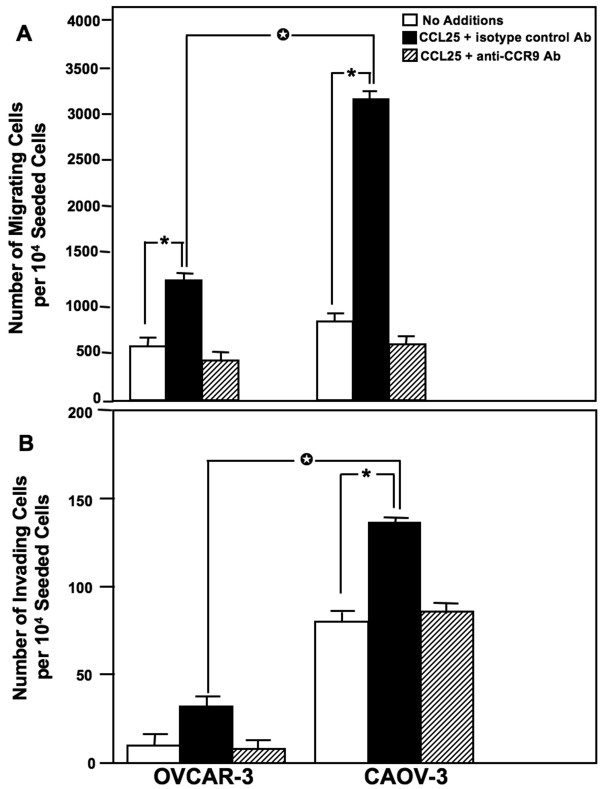
CCR9-mediated ovarian cancer cell migration and invasion. (A) OVCAR-3 and CAOV-3 cells were tested for their ability to migrate toward chemotactic gradients of CCL25. Cells were co-cultured with 1.0 μg/mL mouse anti-CCR9 antibody during migration assays using 100 ng/mL of CCL25. (B) OVCAR-3 and CAOV-3 cells were also tested for their ability to invade or translocate across Matrigel™ matrix in response to 100 ng/mL of CCL25. Cells were co-cultured with 1.0 μg/mL monoclonal antibodies against CCR9 during invasion assays using 100 ng/mL of CCL25. The number of cells ± SEM that migrated or invaded is shown with asterisk(s) that indicate significant differences (p < 0.01) between no additions and chemokine-induced cells.